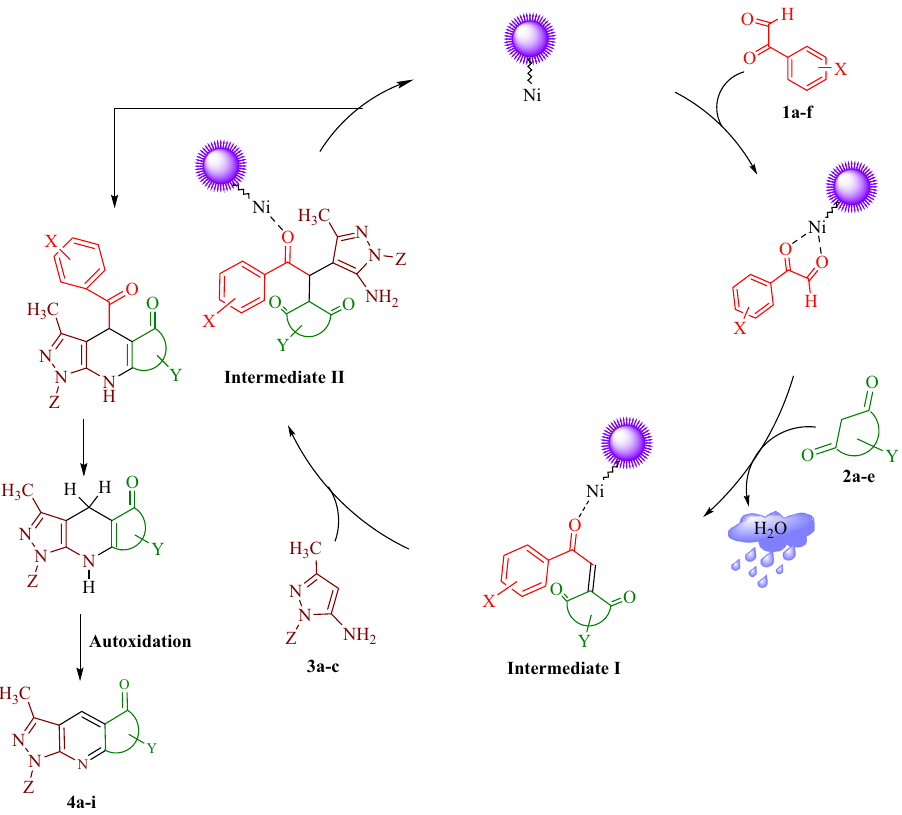
Figure 11. The possible reaction mechanism for the obtaining of compounds 4a-i .